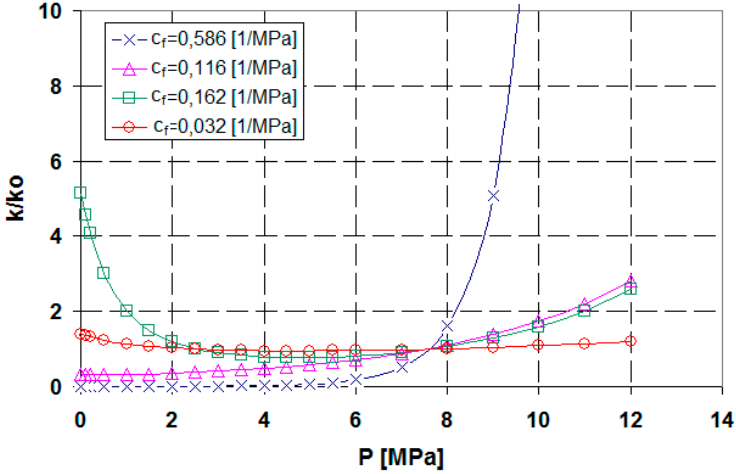
Figure 2. Changes in permeability in relation to changes in the methane pressure based on the Cui and Bustin model [3]. 231